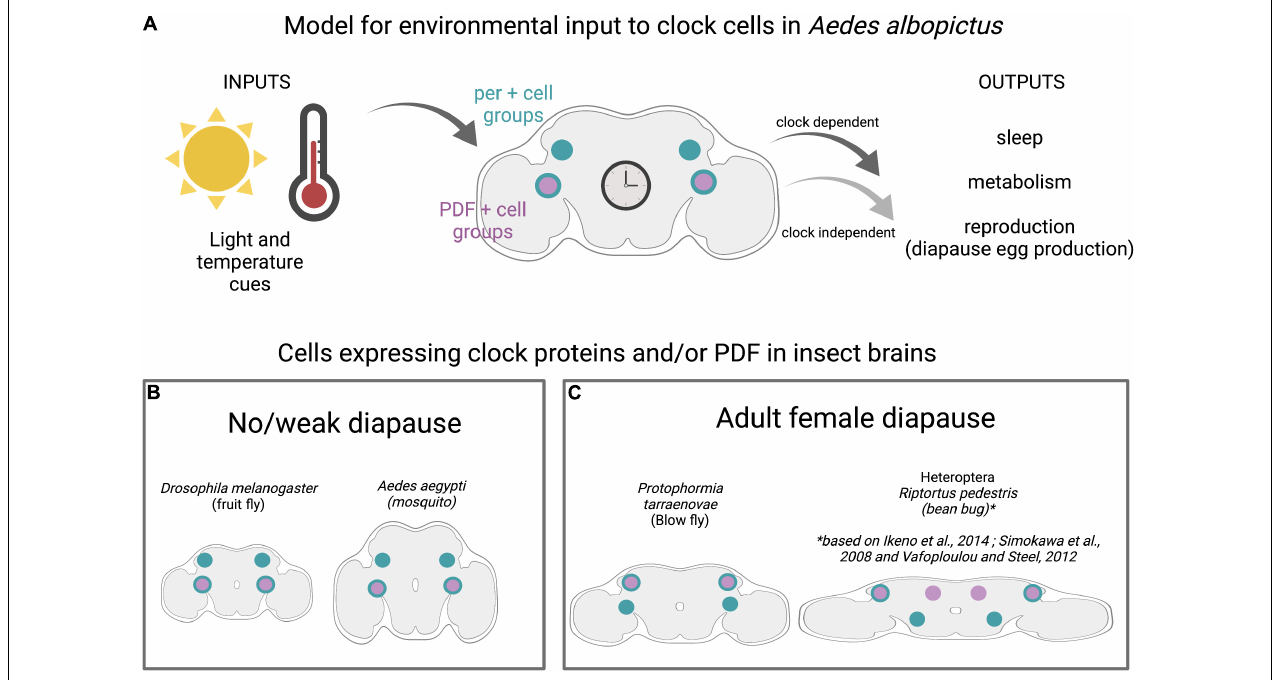
FIGURE 2 | Clock cells in diapausing and non-diapausing insects. (A) Model for environmental inputs to predicted clock cell subgroups in Ae albopictus that are candidates for regulating diapause entry in adult females. Light and temperature cues are detected by central brain clock cells expressing the neuropeptide Pigment Dispersing Factor (PDF) shown in purple and/or core clock genes (denoted by period (per) in teal). Predicted clock subgroups are based on observations in D. melanogaster and Ae. aegypti (Baik et al., 2020). (B) Insects with no/weak diapause and those with adult female diapause (C) show conservation of clock anatomy, including distinct subgroups of central brain cells that express combination of per and